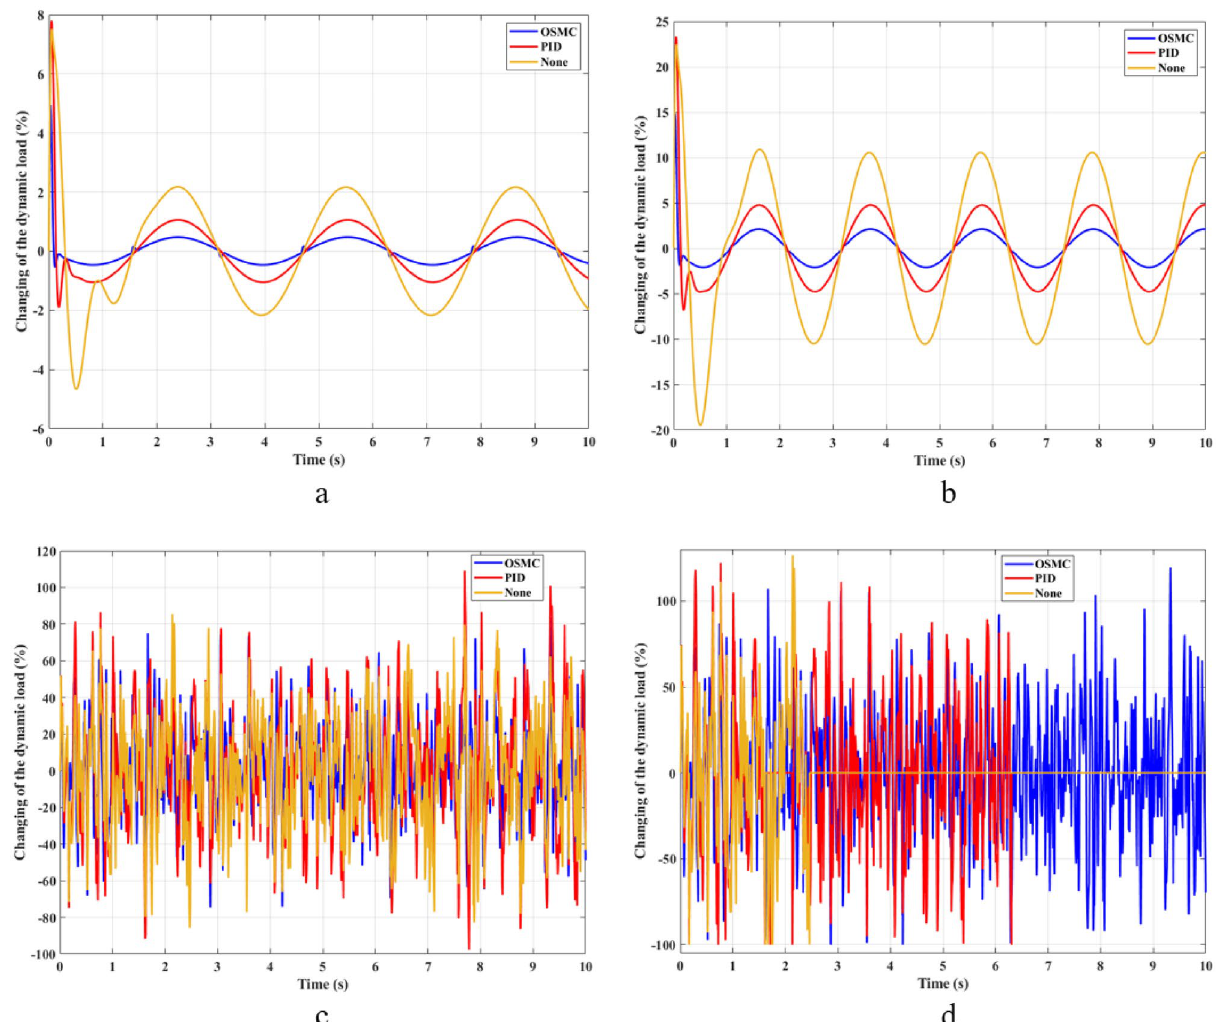
Figure 7. Changing of the dynamic load (( a ) Case 1; ( b ) Case 2; ( c ) Case 3; ( d ) Case